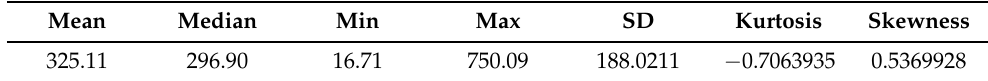
Table 7. Statistical characteristics of the “Total Solar Radiation” dataset.